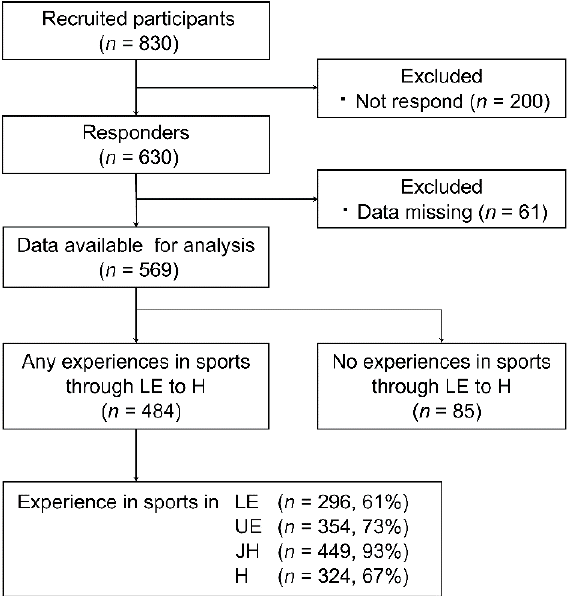
Figure 1. Flowchart of the selection of study participants. LE: lower elementary school, UE: upper elementary school; JH: junior high school; H: high school.